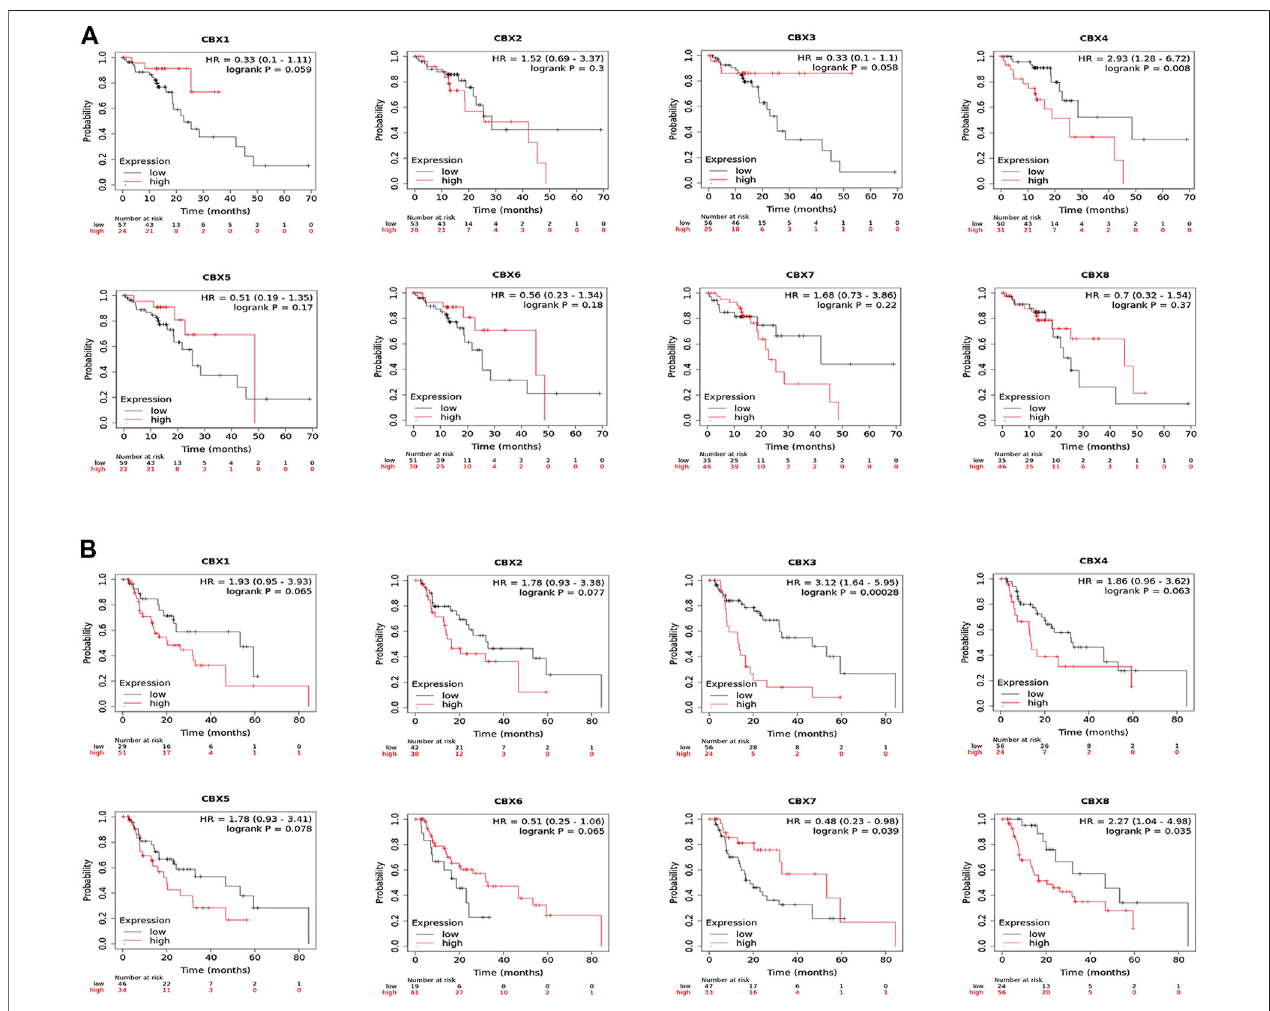
FIGURE 4 | (A) Prognostic value of CBXs in esophageal squamous cell carcinoma (ESCC) patients in the overall survival curve (Kaplan – Meier Plotter). (B) Prognostic value of CBX family members in esophageal adenocarcinoma (EAC) patients in the overall survival curve (Kaplan – Meier Plotter).